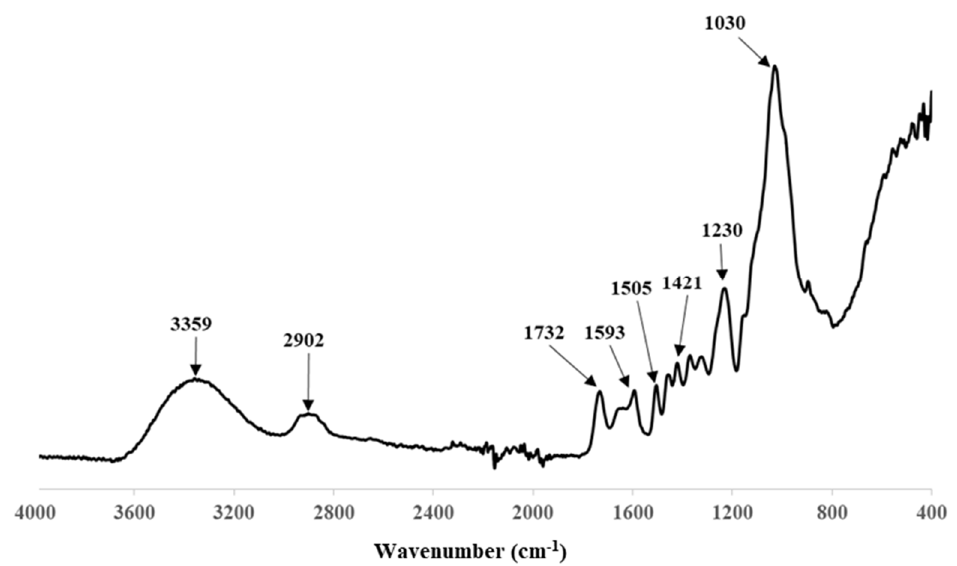
Figure 5. FT-IR performed on OP sample.